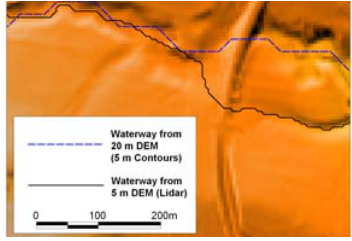
Figure 13. 20 m and 5 m DEM Waterway